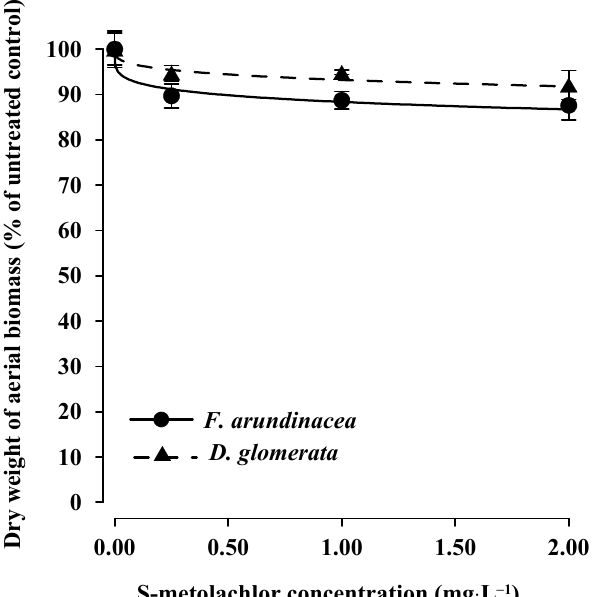
Figure 1. Effects of S-metolachlor (SMR) concentrations on dry weight aerial biomass of F. arundinacea (tall fescue) and D. glomerata (orchardgrass) at 36 DAT (days after treatments). The symbols indicate the observed data, the lines show the fitted curves according to a logistic dose–response model. Vertical bars represent ± standard error.